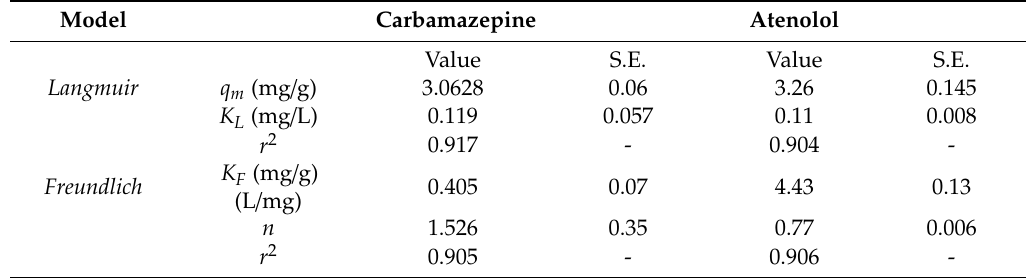
Table 5. q m of adsorption of Contaminants of Emerging Concern (CECs) by A -BBS0.4.